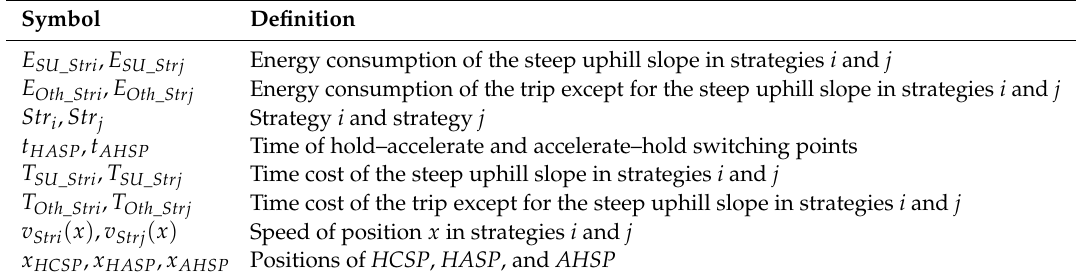
Table 2. Subscripts, parameters, and variables used in the mathematical formulations.